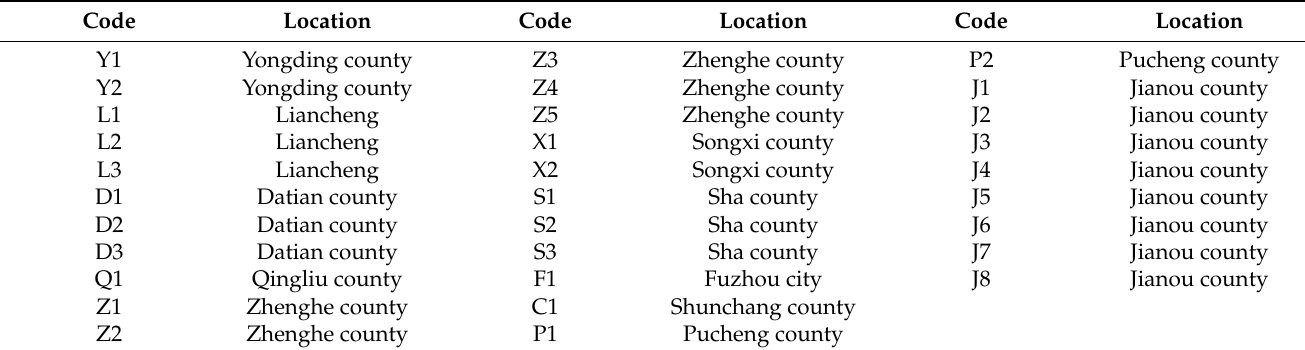
Table 1. Origin of H. acerba test germplasm resources.